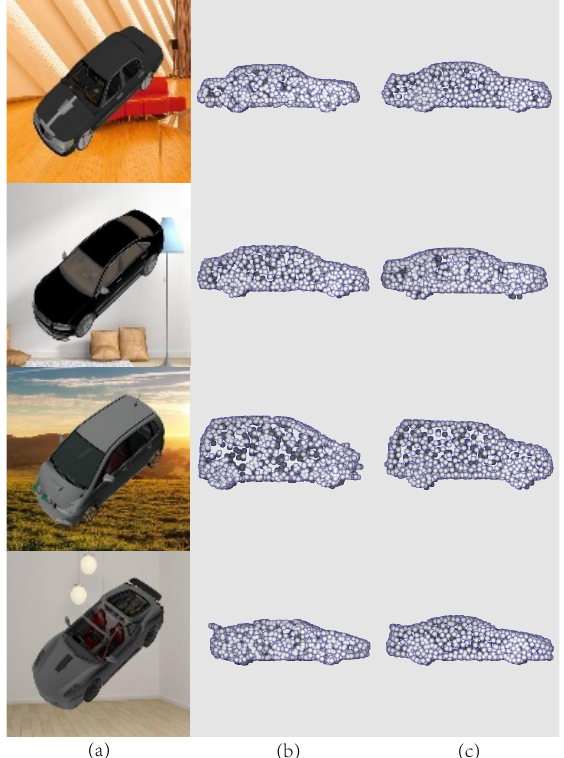
Figure 7. Results on rendered images. ( a ) Rendered images. ( b ) Ground truth. ( c ) Generated point clouds by PCCNet